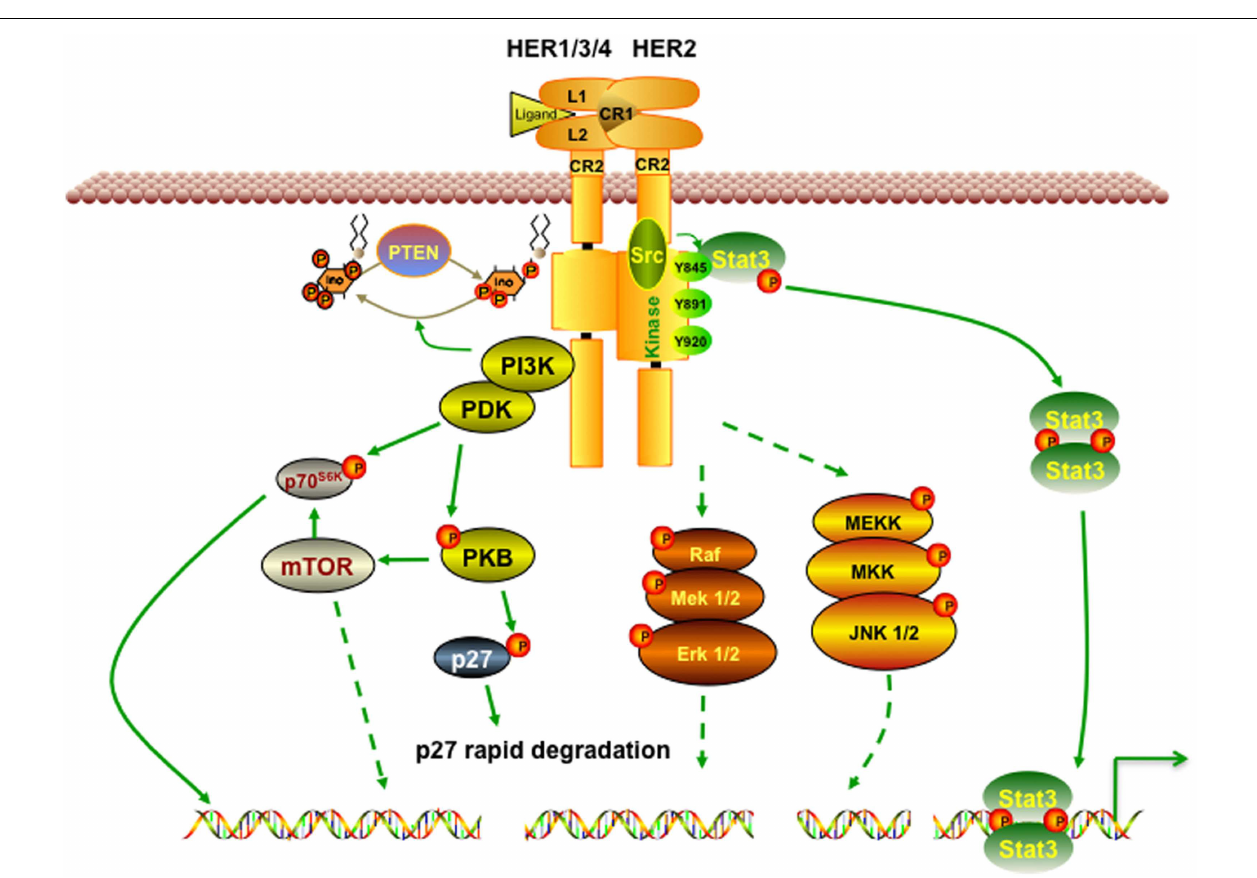
one of the most well studied pathways activated by HER2. Activated PI3K/Akt also triggers mTOR, a master positive regulator of cell metabolism. In addition, HER2 activation can activate Ras/Raf and MEK pathways, which favors cancer cells’ growth and